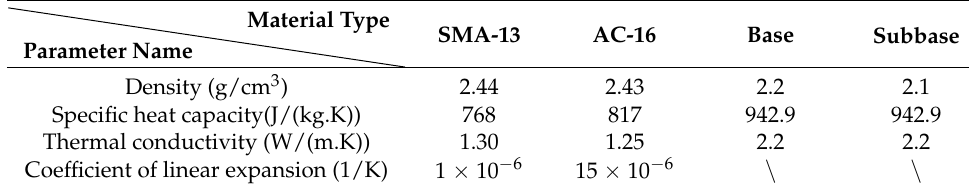
Table 1. The material